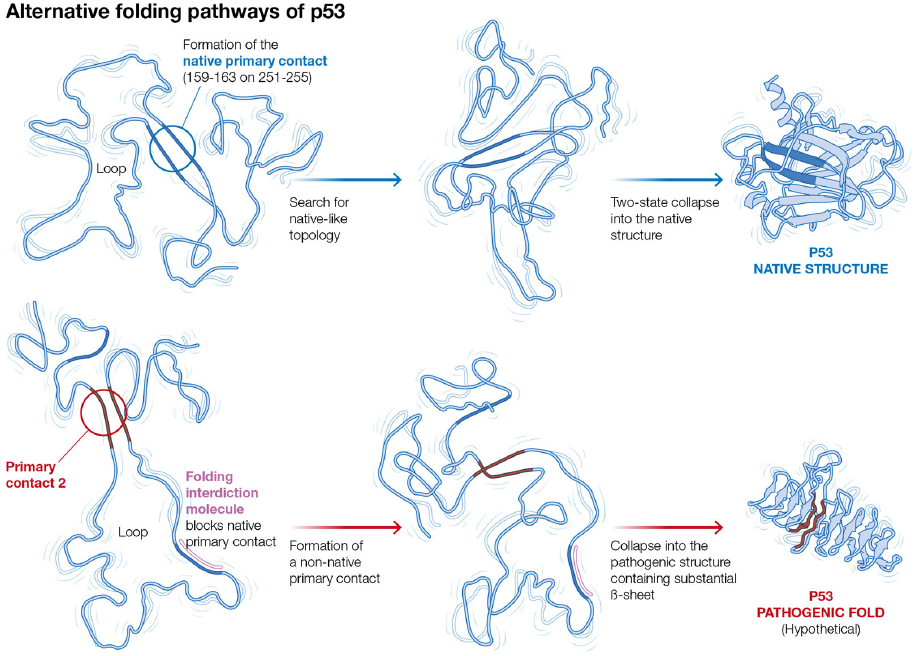
Figure 4. Hypothetical misfolding mechanism of core p53 triggered by interdiction with peptide